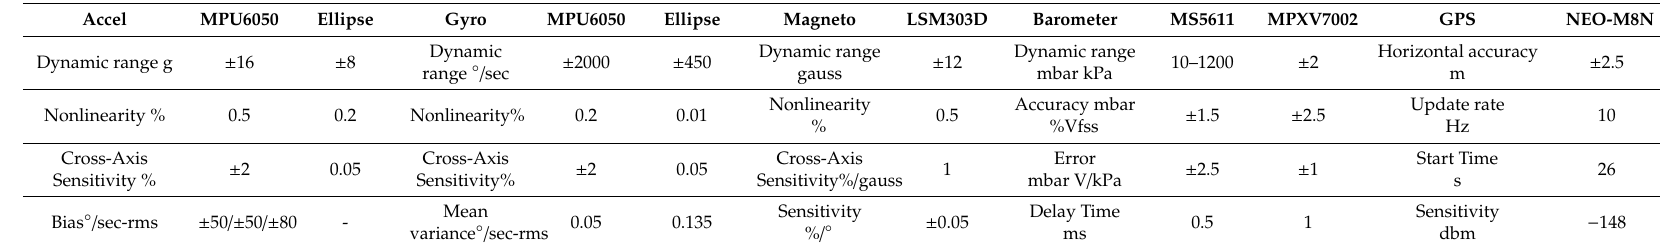
Table 1. Various sensors with measurement